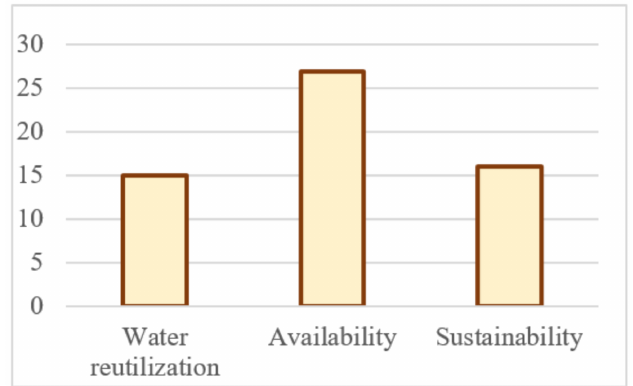
Figure 4. Combined data of the most beneficial advantages of using reclaimed water perceived by farmers.